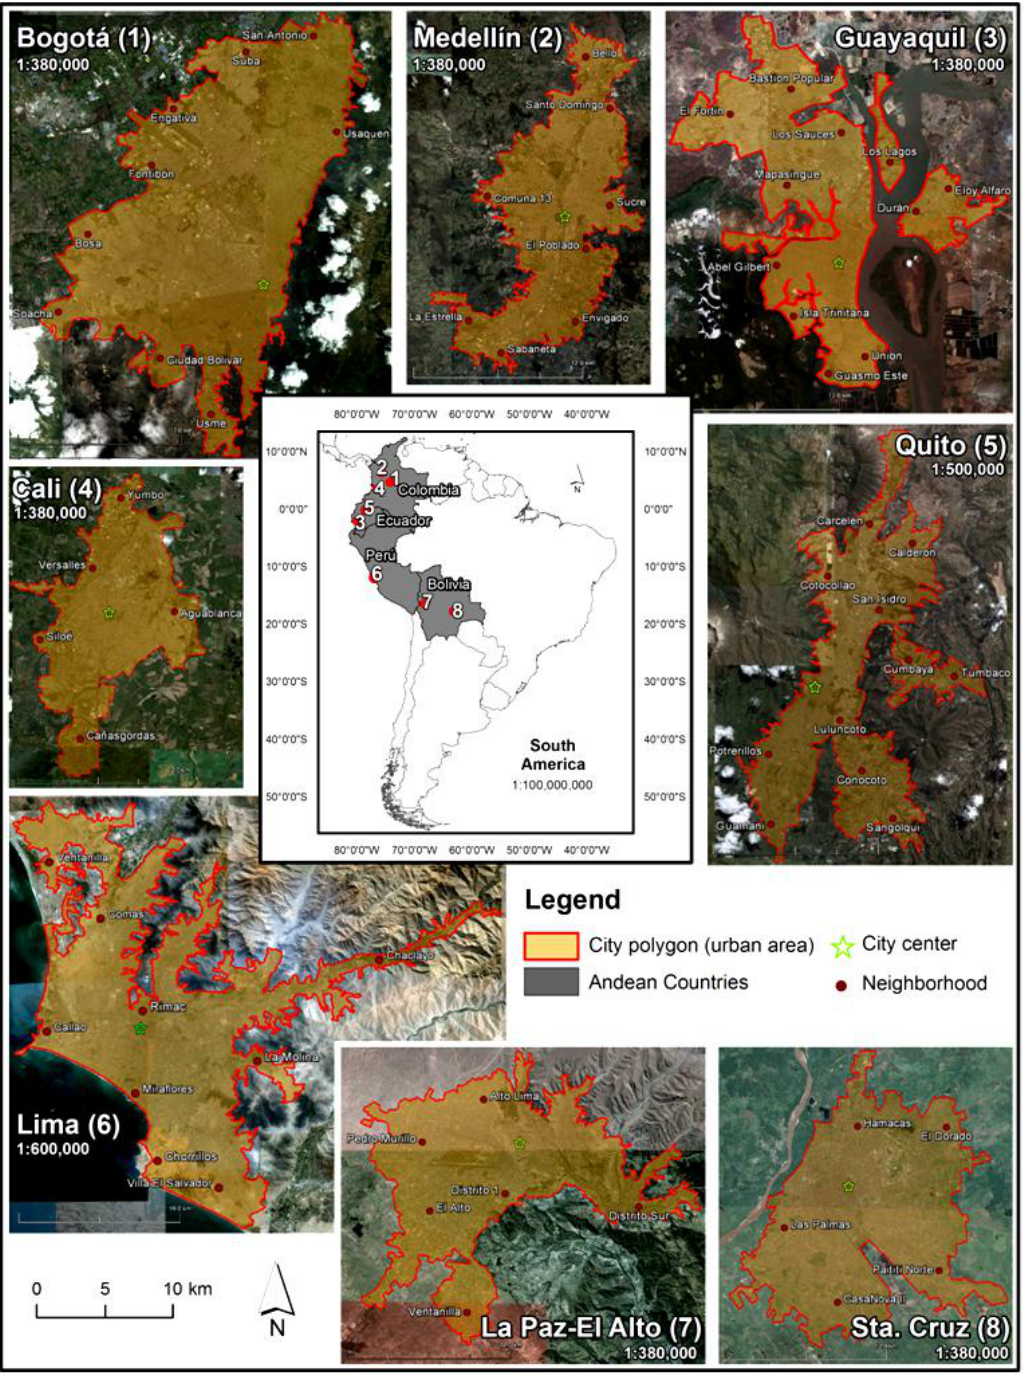
Figure 1. Map of the Andean region in South America and location of the eight cities studied. Includes the city polygons ( i.e. , urban area), delimited using images from Google Earth between 2007 and